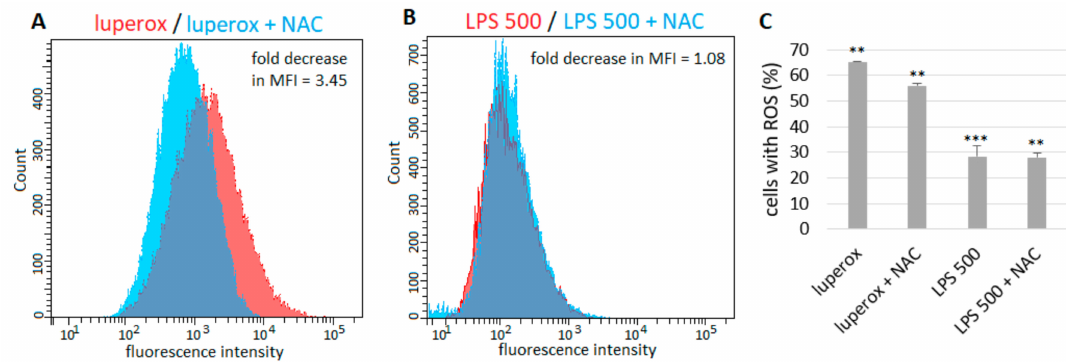
Figure 4. The e ff ect of NAC on ROS + A549 cells. The numbers of ROS + fluorescent cells were about 9% lower in samples cultured in the presence of 10 mM NAC compared to cells treated with Luperox only ( A ). NAC did not show any e ff ect on cells exposed to LPS ( B ). ( C ) The percentage of ROS + fluorescent cells after treatment with luperox or 500 µ g / mL LPS alone and in combination with NAC. Untreated cells represent basal (zero) line. Data are presented as means ± SDs from three independent experiments. ** p < 0.01, *** p < 0.001. LPS—lipopolysaccharide, NAC— N